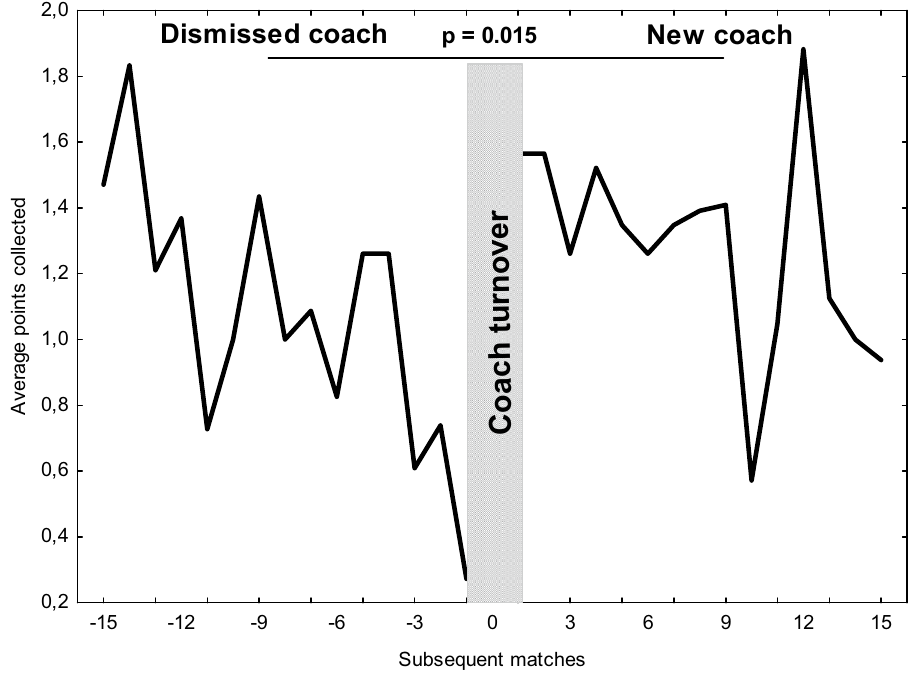
Figure 1. Average points collected by dismissed coaches during their last 15 matches and new coaches in their first 15